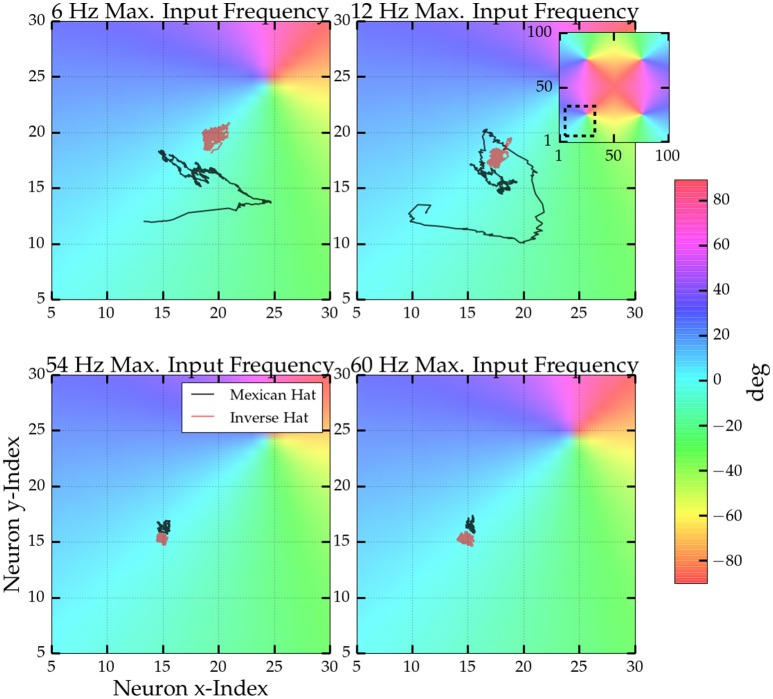
Trajectories of the center of activity at one pinwheel for four different maxium driving frequencies. Colors indicate the orientation preferences of the model neurons. The inset shows which part of the full orientation map is depicted. Centers were computed from the activity within a sliding window of 250 ms length. Every neuron's position was interpreted as a vector in the 2D plane and the trajectory is the average vector weighted by the neurons activity within the sliding window. Black line: Trajectories for a Mexican hat network (parameters as in Figure 6) and a stimulus oreintation of 1°. Red lines: Trajectories for an inverse Mexican hat network (σE = 15 px > σI = 10 px) with the same connections strengths and a stimulus orientation of 0°.